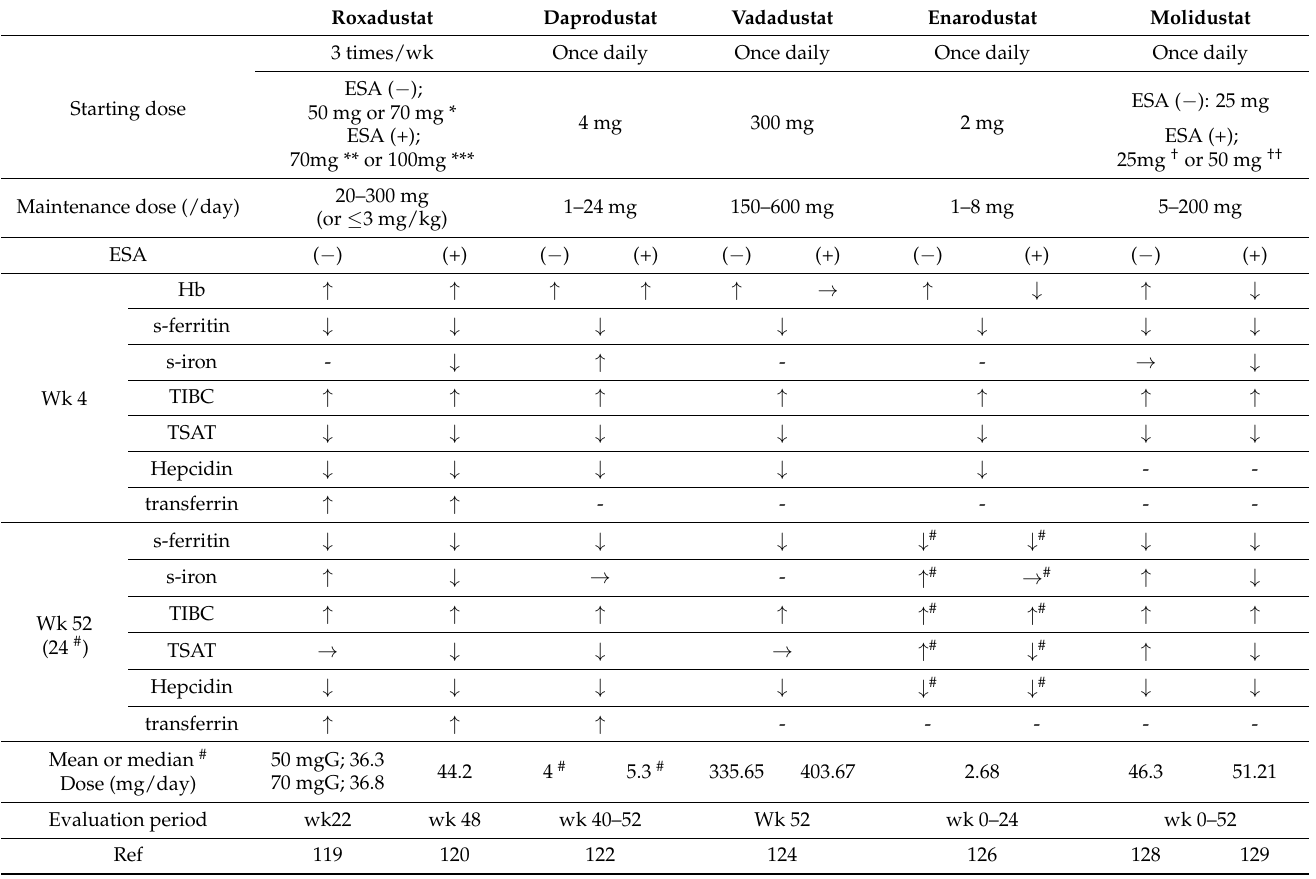
Table 1. Change from baseline in Hb and iron-related factors during HIF-PHI therapy in non-HD patients. Roxadustat Daprodustat Vadadustat Enarodustat